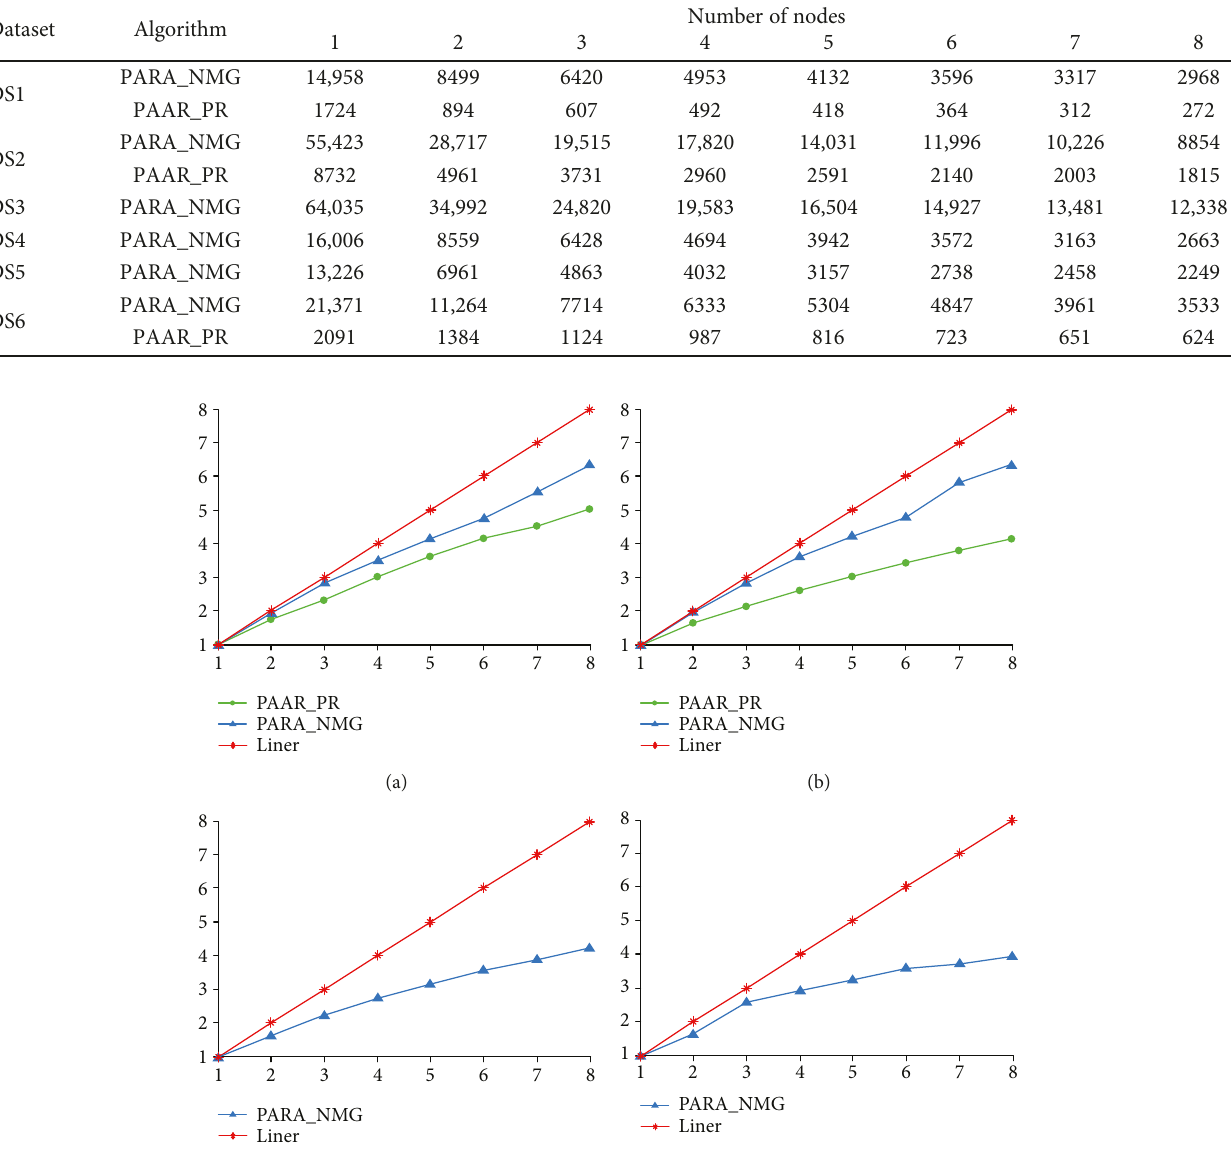
Table 5: Average computational time of two algorithms ( s ).